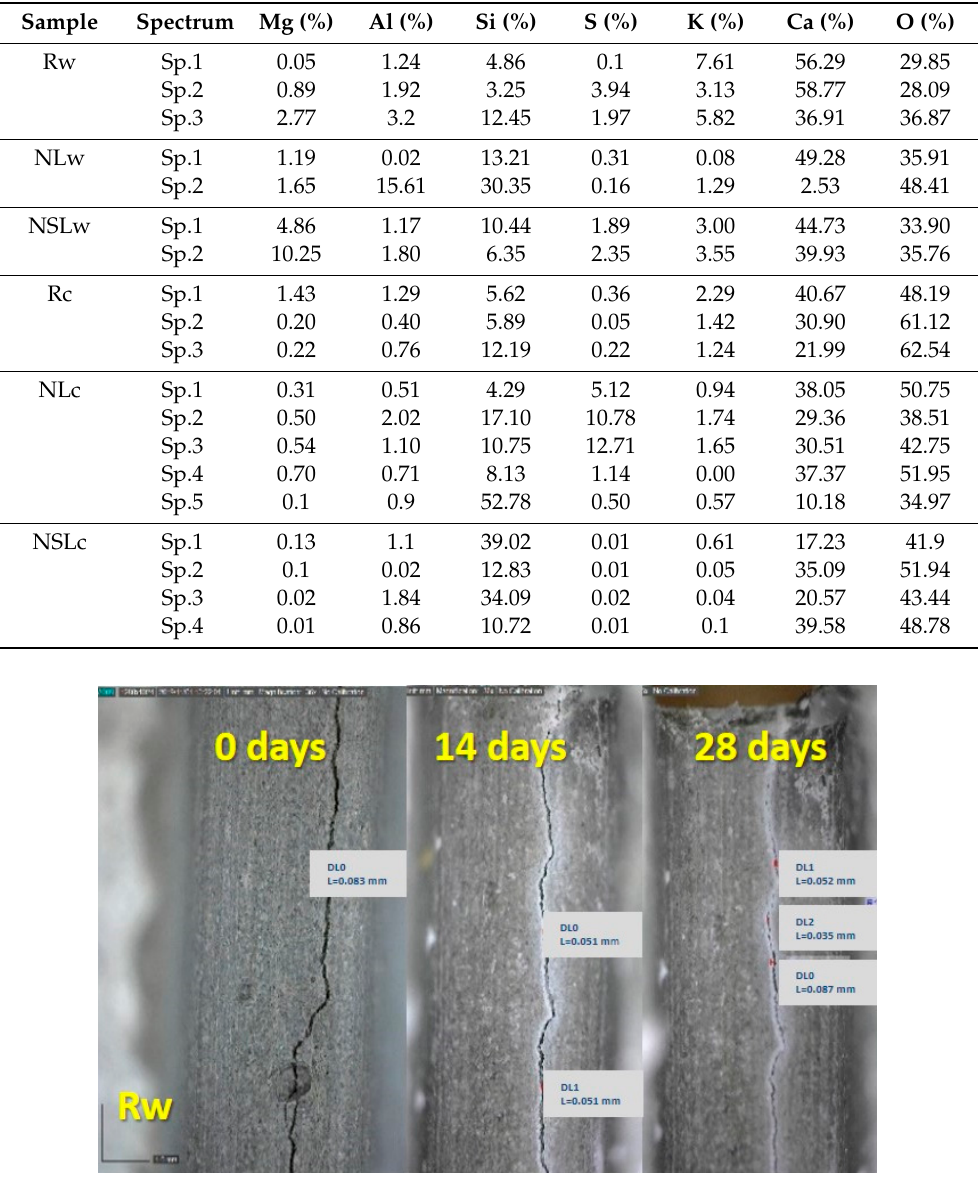
Table 5. EDS analysis of the micrographs shown in Figure